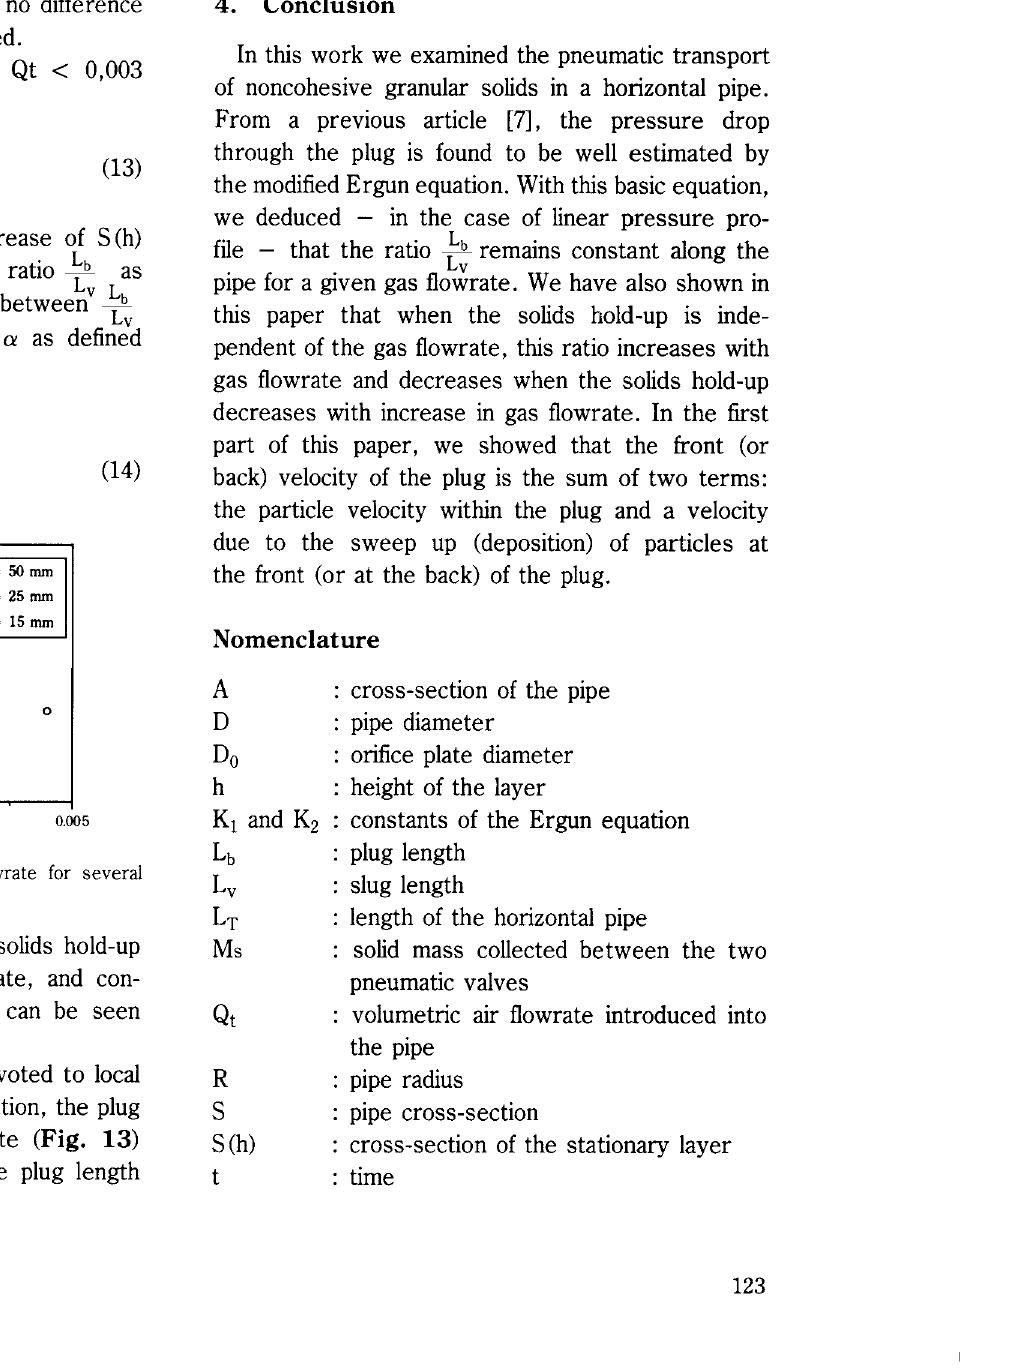
Fig. 11 Variation of solids flowrate with inlet gas flowrate for several plate diameters